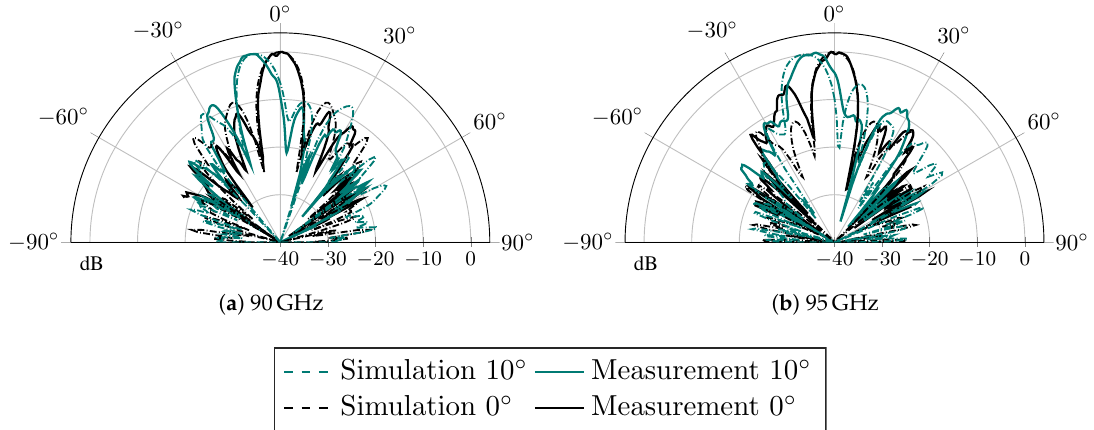
Figure 38. Simulated and measured pattern of the fully dielectric antenna array at different